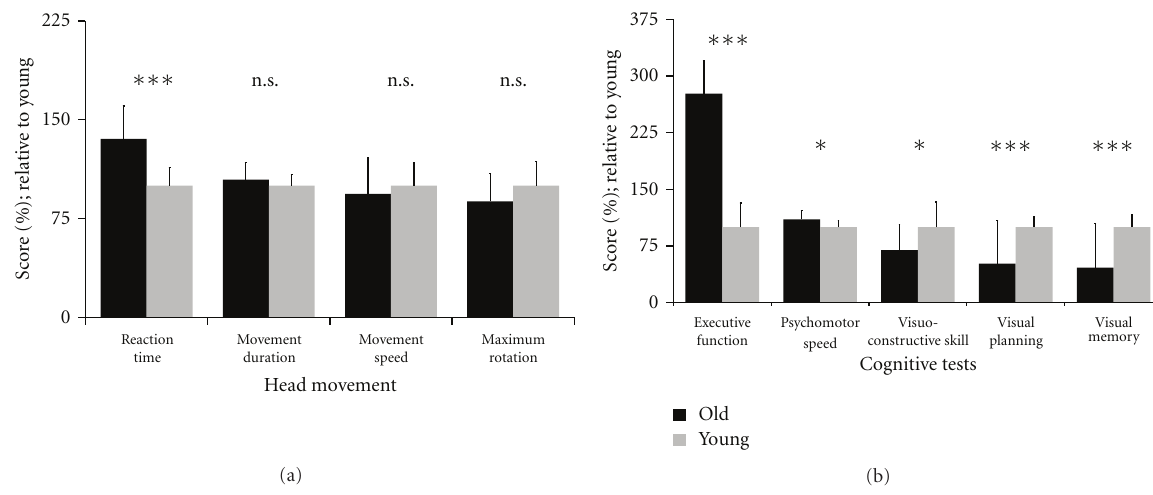
Figure 2: Measures of head movement (a) and of cognition (b). To facilitate comparisons, raw scores were transformed into percentages of young subjects’ means. The means of older subjects are depicted by black blocks, and those of young subjects (i.e., 100%) by gray blocks. Error bars represent the standard errors ∗∗∗ indicates P < . 001, ∗ indicates P < . 05, and n.s. indicates no significance. Note that “executive function” and “psychomotor speed” are time based parameters such that lower scores indicate better performance.